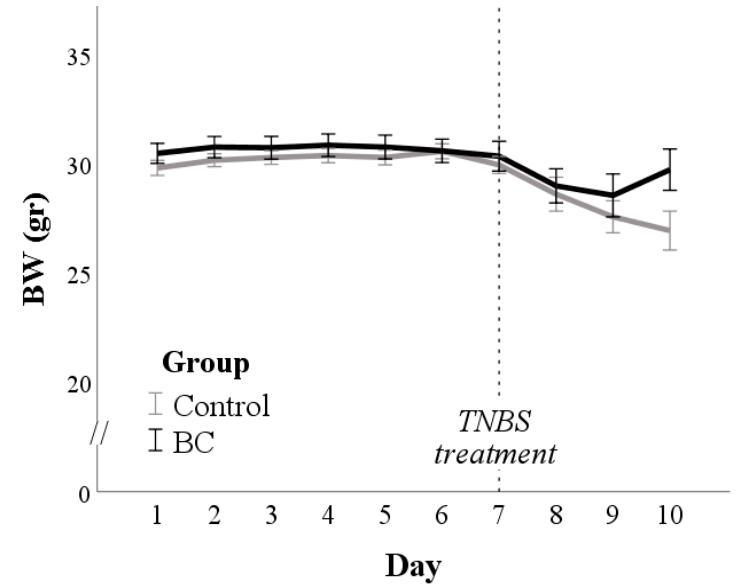
Figure 1. Bodyweight (BW) changes in control and bovine colostrum (BC) groups. The dotted line indicates the day of TNBS treatment.